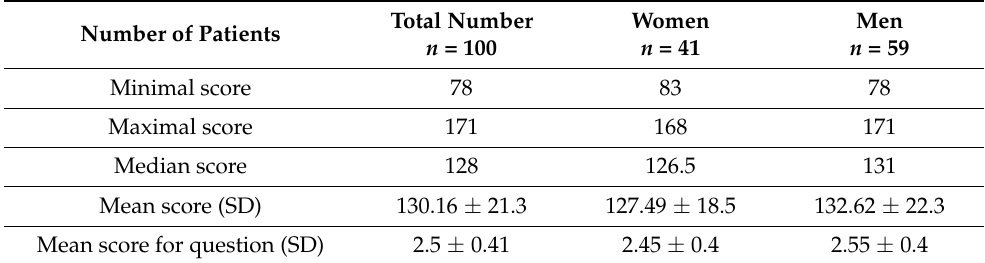
Table 2. Intensity of chronic self-destructiveness in patients with HS—the overall CS-DS score. Total Number of Patients